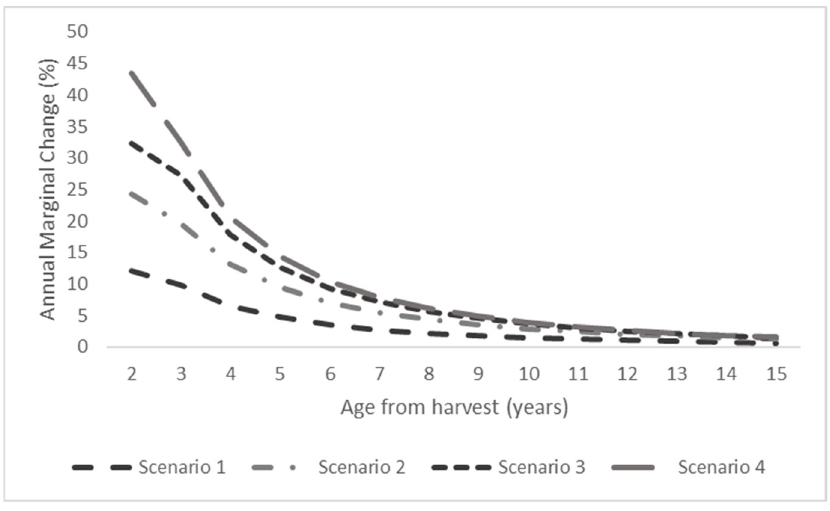
Figure 3. Annual marginal change in option value.